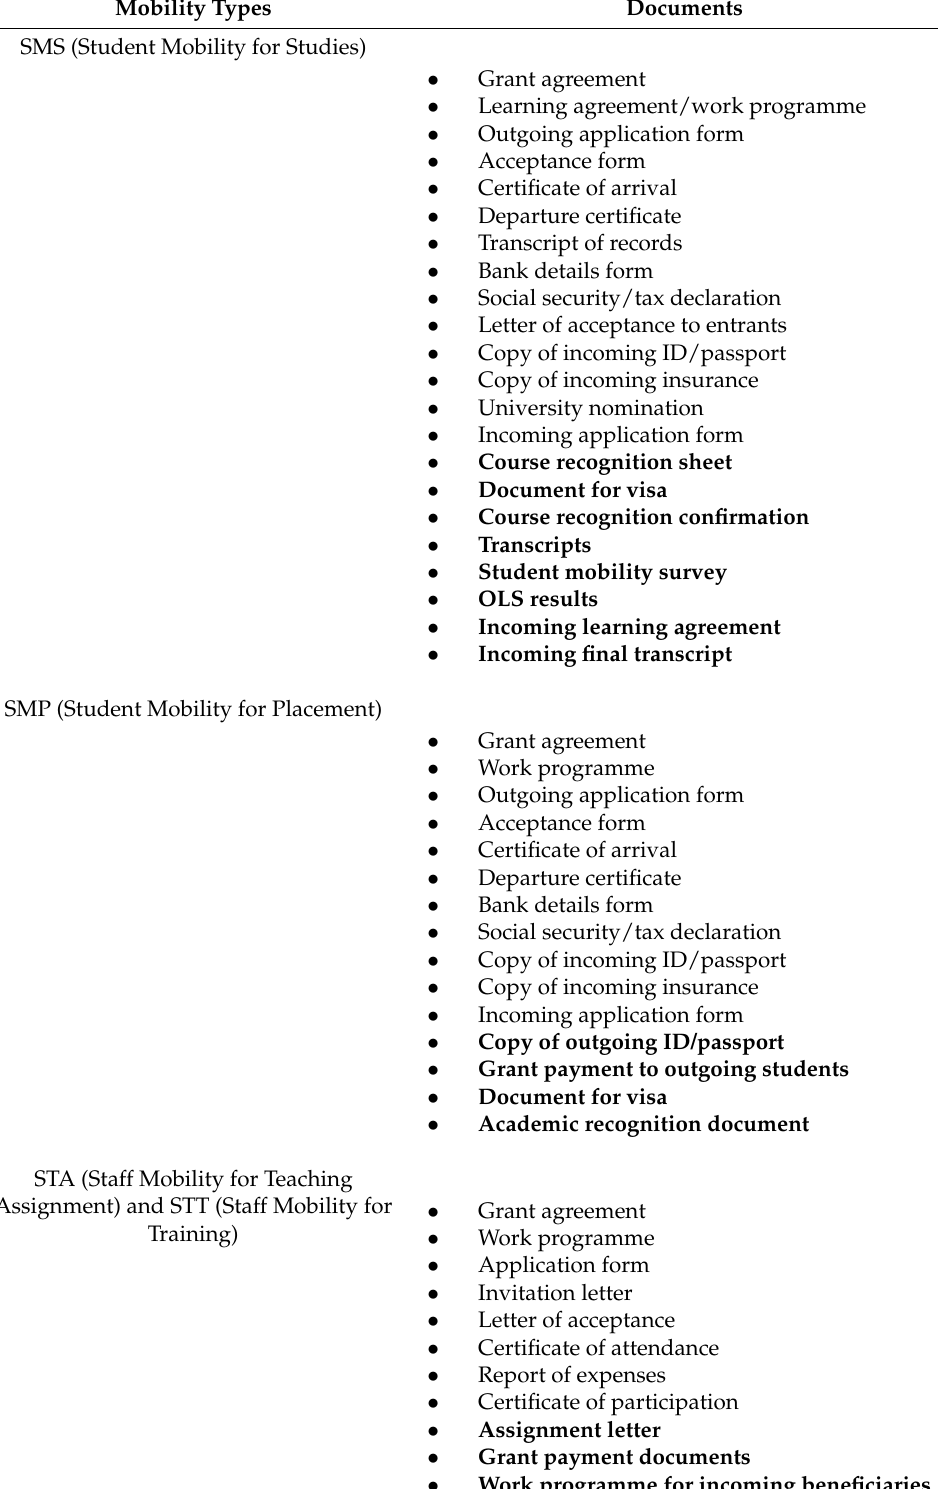
Table 1. Documents counted for the four types of mobilities ( bold documents are used by some institutions